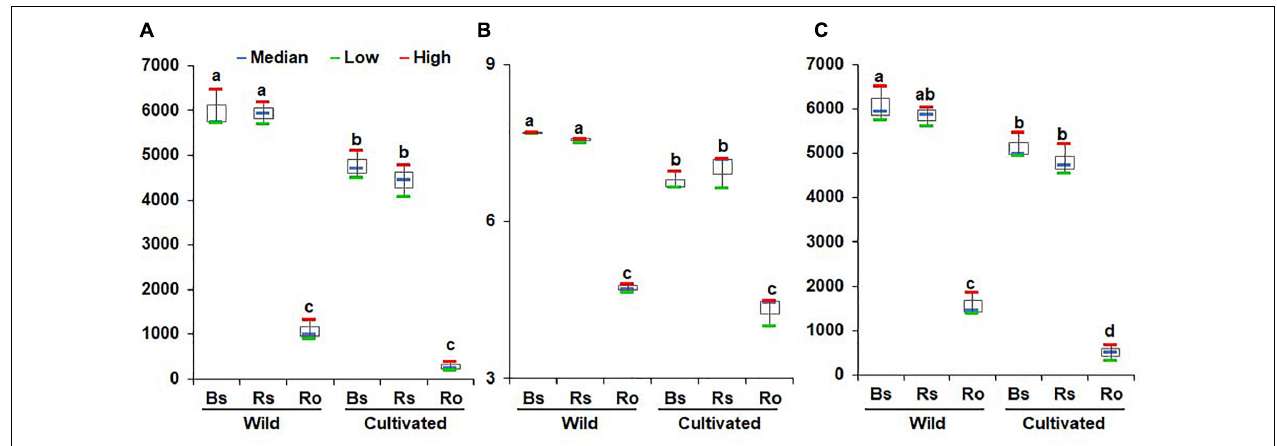
FIGURE 1 | Comparison of richness and diversity of bacterial communities between rhizocompartments in wild habitats and cultivated areas. Richness was quantified by the Chao1 estimator (A) , species evenness was represented by Shannon’s index (B) , and biodiversity incorporating phylogenetic difference between species was measured through phylogenetic diversity (C) . Red and green bars represent high and low while horizontal blue bars within boxes represent median. The tops and bottoms of boxes represent the 75th and 25th quartiles, respectively. Diversities were compared between bulk soil (Bs), rhizosphere soil (Rs), and root (Ro) in wild habitats and cultivated areas. Different letter(s) indicate significant difference at P =